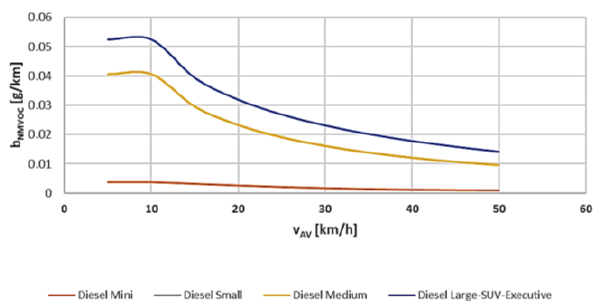
Fig. 25. NMVOC emission from diesel oil PCs for vehicle segments depending on average speed